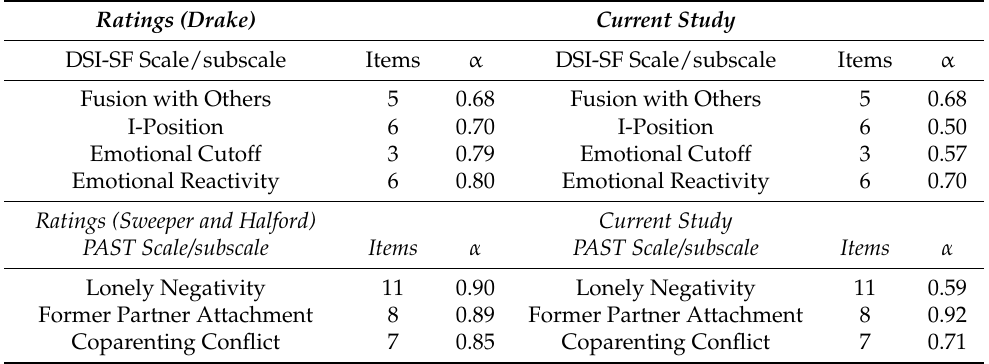
Table 1. Comparison of reliability coefficients for measures for the original and current